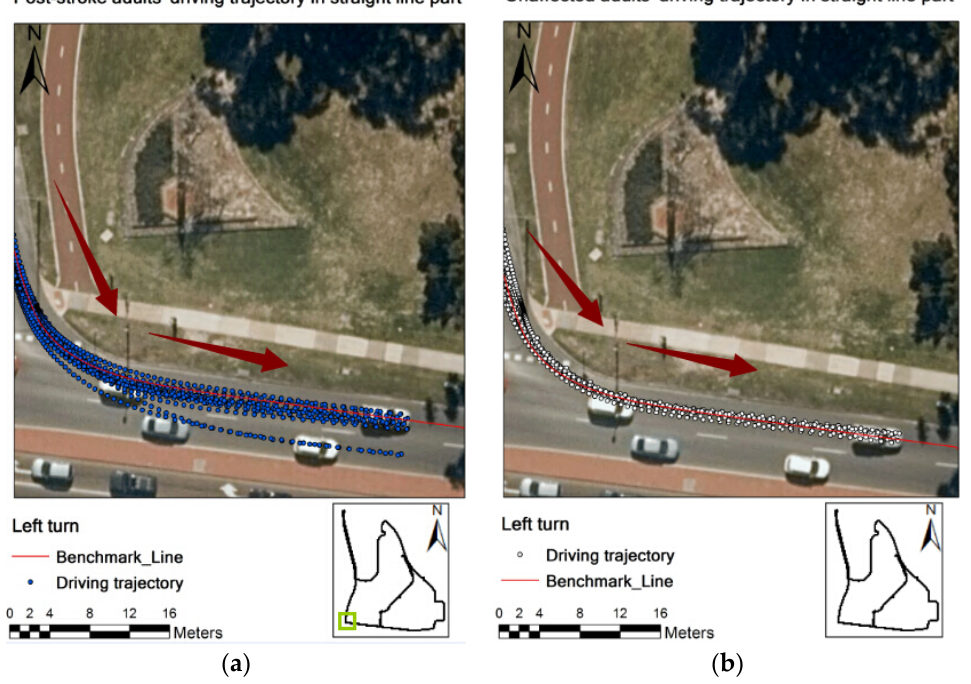
Figure 4. Driving trajectory of post-stroke ( a ) and normal ( b ) groups in left turn.